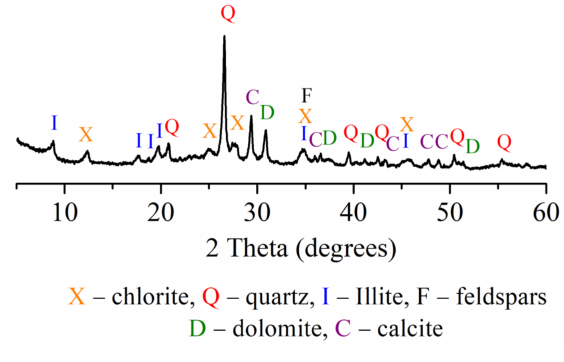
Figure 1. Clay XRD analysis.